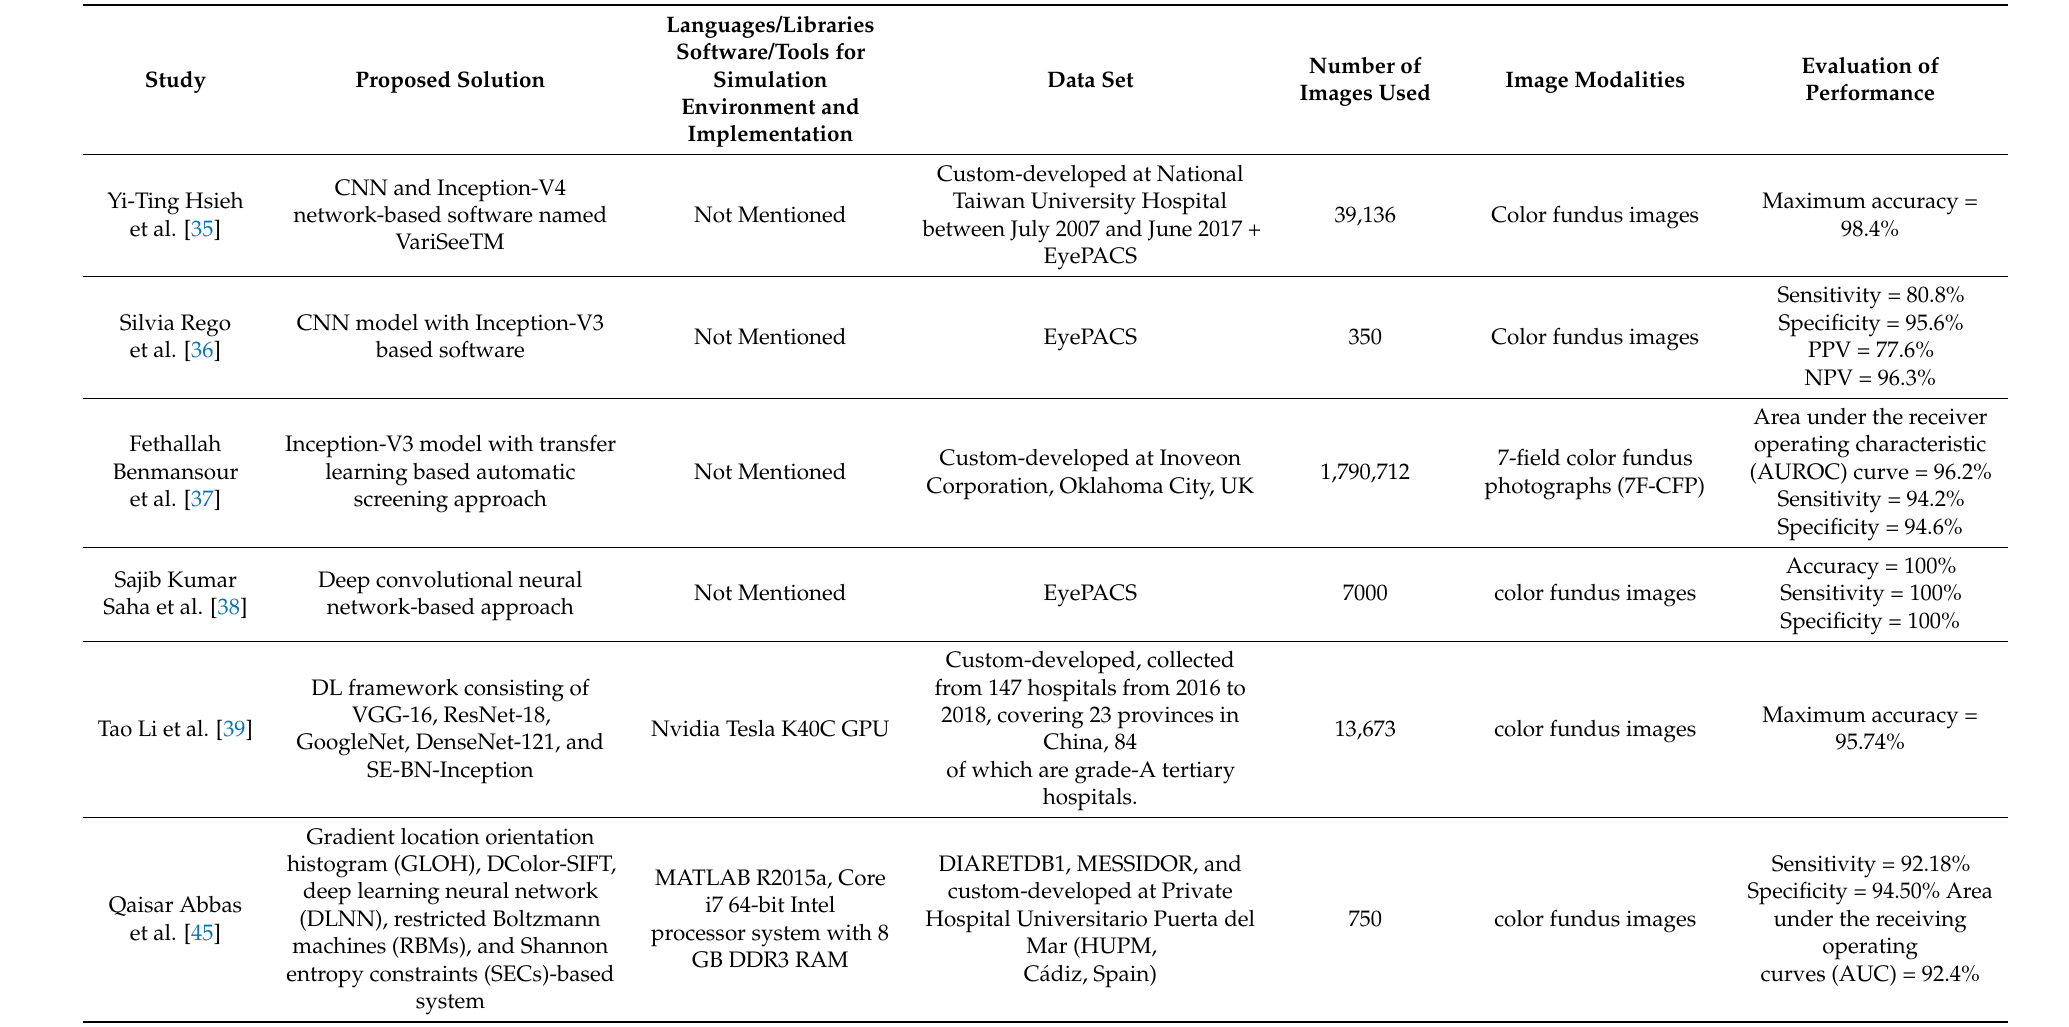
Table 1. A comparison of reported deep learning techniques for screening and